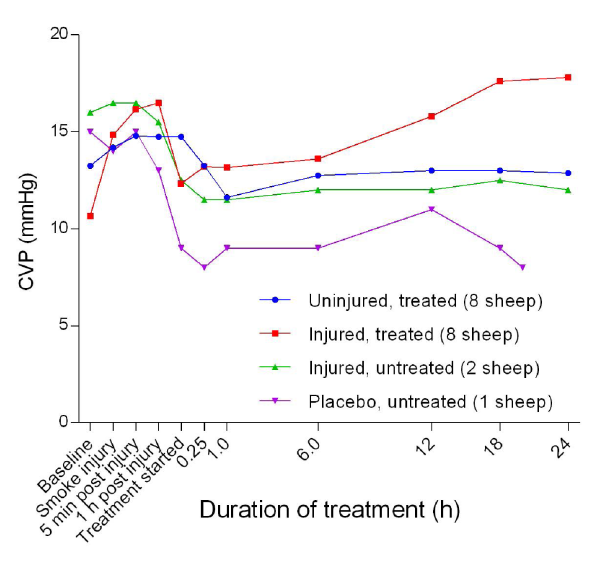
Figure 27. Continuous cardiac output (CCO) (Mean ± SD, error bars not shown) in smoke and non-smoke injured sheep that received extracorporeal life support as compared to that in untreated controls.